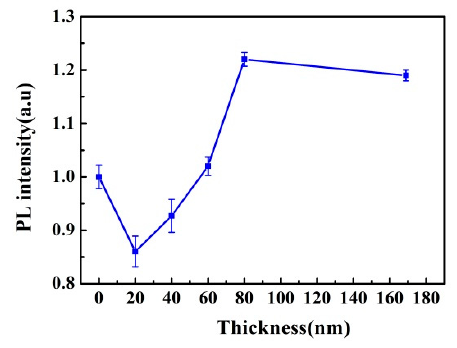
Figure 8. The influence of SiO 2 thickness on PL intensity.